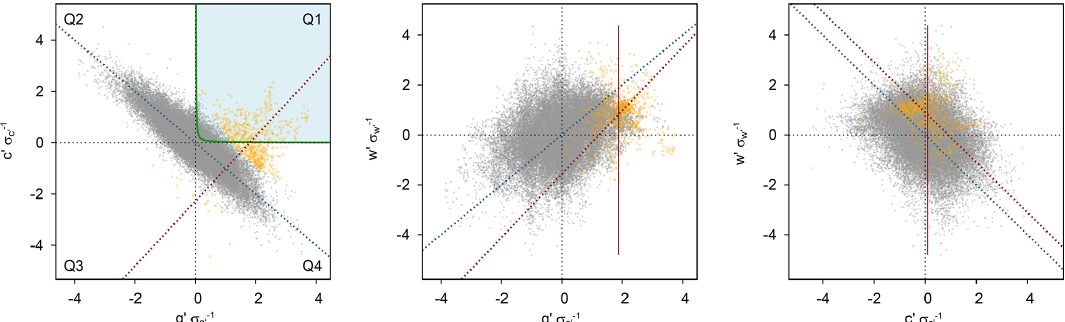
Figure 1. Exemplary scatterplots of w (cid:48) , q (cid:48) , and c (cid:48) from the Wüstebach study site (forest), 18 May 2015, 12:00–12:30LT (local time), including results of the cluster analysis by Gaussian mixture model (orange data points) for the conditional sampling. Also shown are the hyperbolic threshold ( H = 0 . 25, green line) after Thomas et al. (2008), the averages of q and c only considering data points of the respiration–evaporation “cloud” (red lines), and reduced major axis regression lines after Webster (1997) for all data points (blue dashed lines) and only cloud data points (red dashed lines). In this example, calculating the covariance for w and c considering the CO 2 average of the cloud yielded a negative soil flux (negative correlation). Thus, only cloud data points within quadrant 1 in the original q (cid:48) – c (cid:48) plane were considered for flux calculation using averages of all data